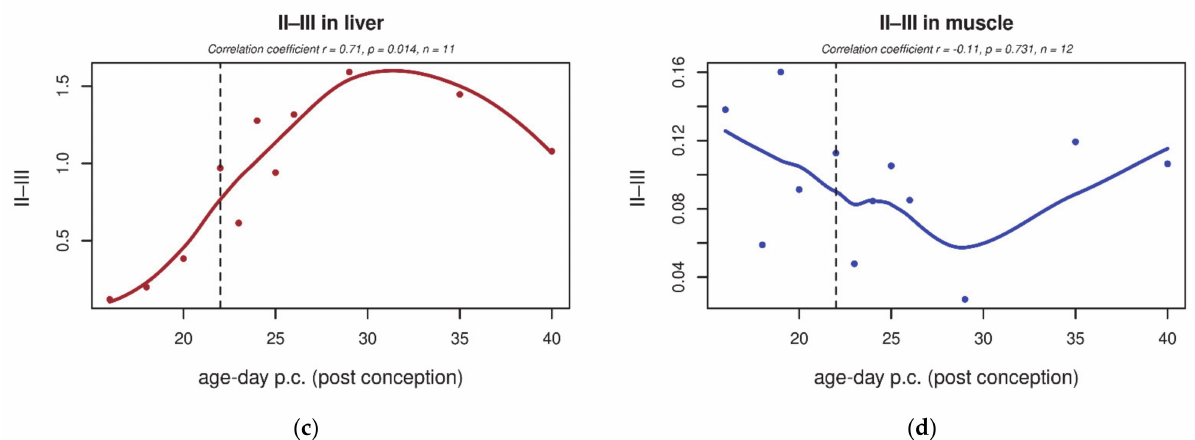
Figure 4. Tissue-specific changes in electron transport chain (ETC) complexes’ coupled activities in rat liver and skeletal muscle during early development. ( a , c ) In the liver, coupled activities of complexes I–III and II–III significantly increased after birth ( p < 0.05). ( b , d ) Contrary to observations in the liver, a significant increase in activities of complexes I–III and II–III was absent in skeletal muscle. Enzyme activities normalised to citrate synthase are shown. The dashed line indicates the last foetal day/birth. I–III—NADH:cytochrome c oxidoreductase, II–III—succinate:cytochrome c oxidoreductase.